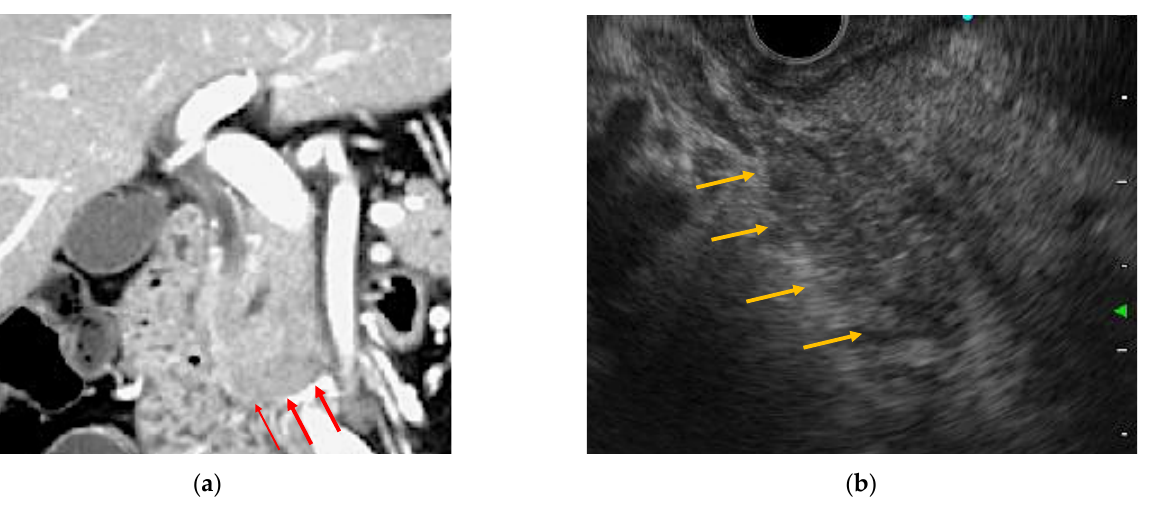
Figure 1. Endoscopic ultrasonography and contrast-enhanced computed tomography (CT) images of immune checkpoint inhibitor (ICI)-related pancreatitis. ( a ) Focal pancreatic enlargement at the pancreatic head with a mass-like lesion and poor contrast enhancement (arrowhead). ( b ) Focal hypoechoic mass-like findings with internal hyperechoic spots from the pancreatic head to the pancreatic uncinate process